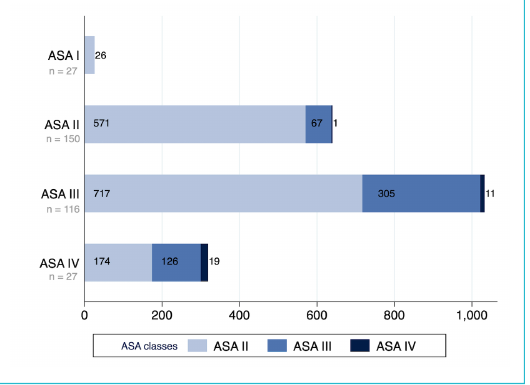
Figure 4: Number and severity of comorbidities according to ASA class. Number and severity of all anaesthesia-relevant comorbidi- ties for all patients in the corresponding overall ASA class. The ASA class of each comorbidity has been assigned as if this comor- bidity would have been the only one in this patient.